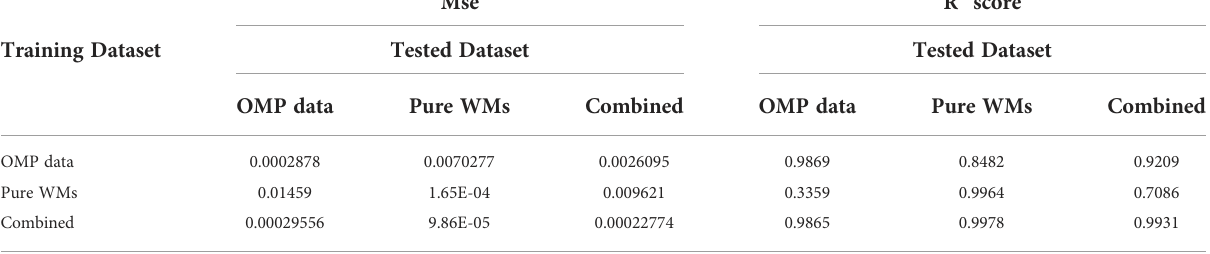
TABLE 4 Minimum square error (mse) and R 2 score of the Extremely Randomized Trees models when evaluated in the three testing sets: OMP dataset, pure WMs dataset, and combined OMP and pure WMs dataset for each of the trained dataset. Mse